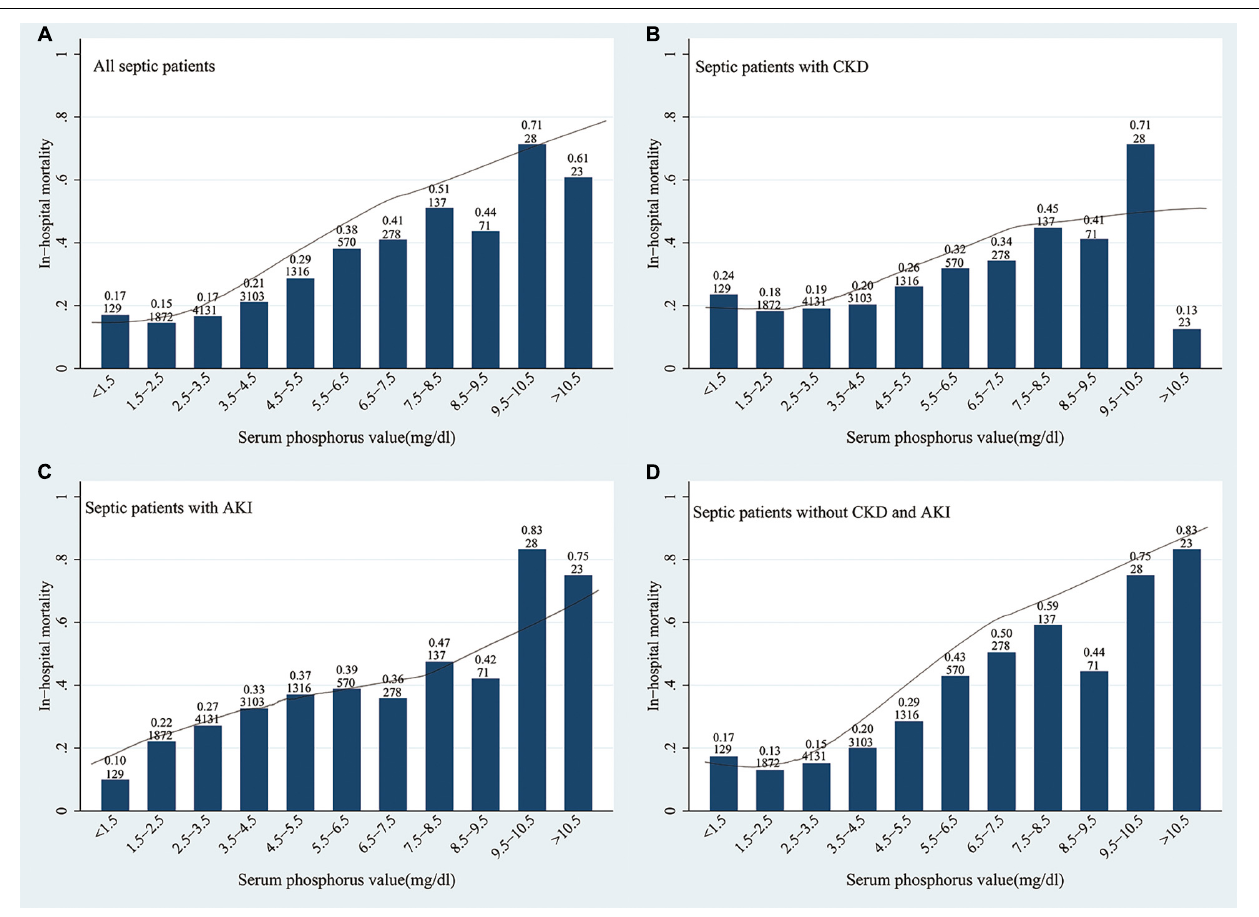
FIGURE 2 | Association between serum inorganic phosphate (Pi) and the in-hospital mortality of patients with sepsis with (A–C) or without (D) chronic kidney disease (CKD) and acute kidney injury (AKI). A nearly linear relationship was found in this figure, especially in the overall population (A) and the AKI subgroup (C) . Pi, inorganic phosphate; CKD, chronic kidney disease; AKI, acute kidney injury. The legends on the top of each bar mean the in-hospital mortality and number of admissions in each serum Pi group.